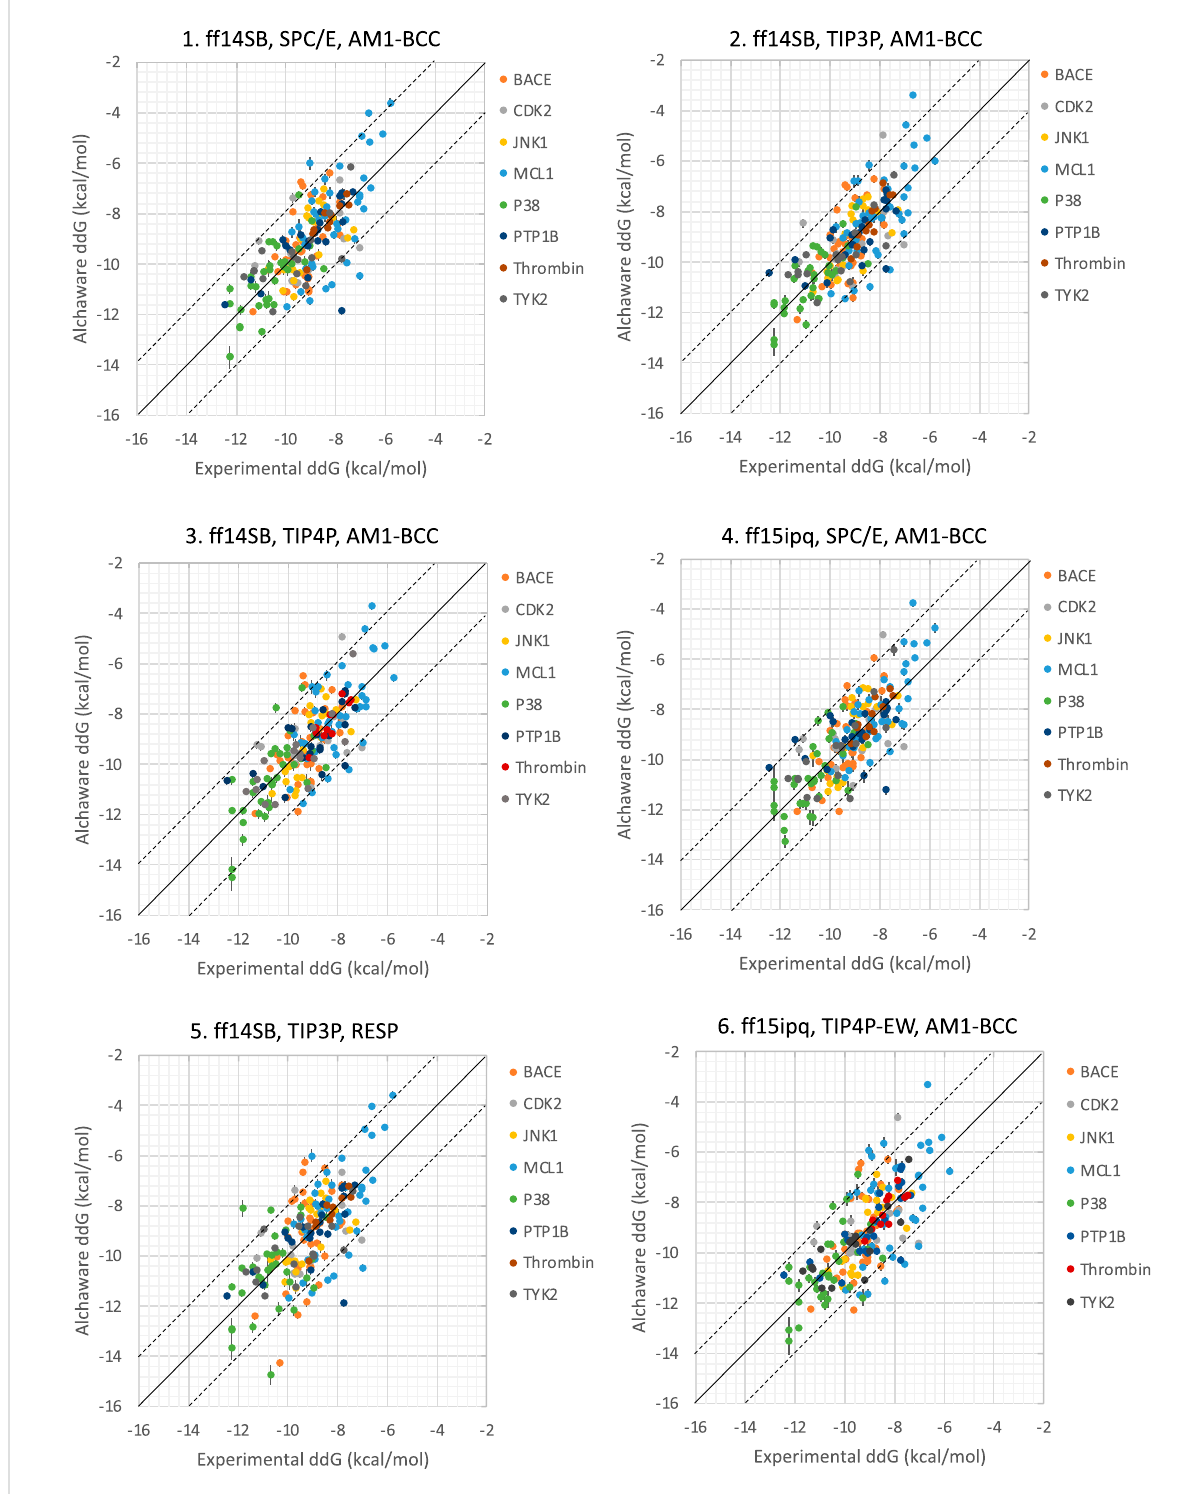
FIGURE 3 Correlation between predicted binding free energies and experimental data with 6 parameter sets. Error bars indicate the cycle closure